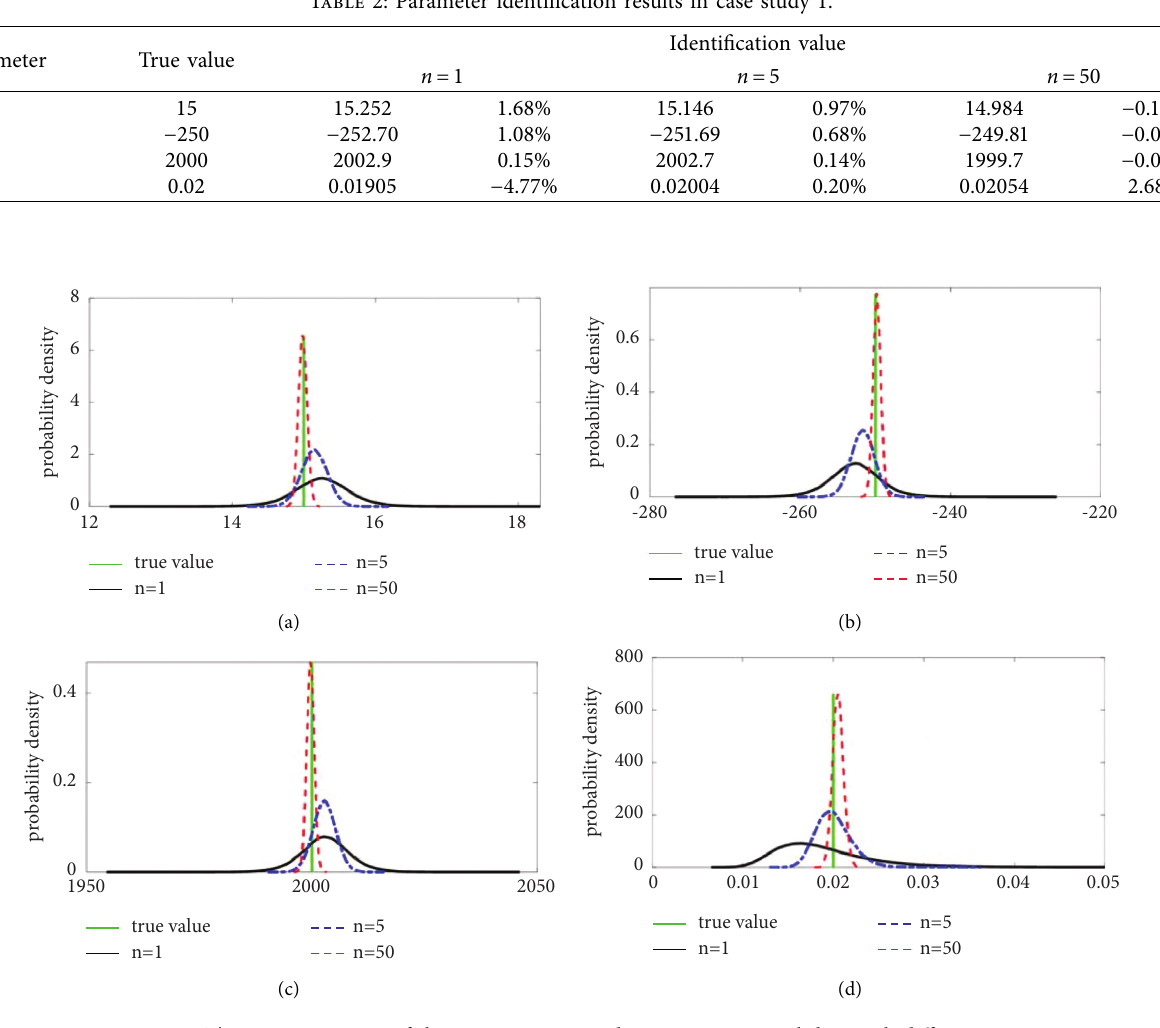
Figure 7: The posterior PDFs of the parameters according to experimental data with different